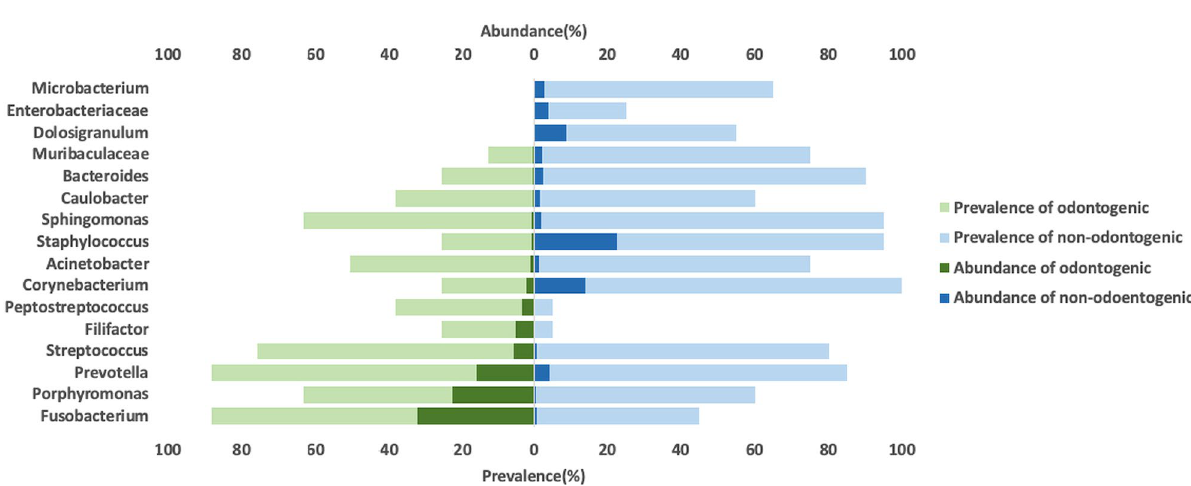
Figure 4. Relative abundance and prevalence based on 16S sequencing data in odontogenic and nonodontogenic rhinosinusitis samples. Abundance was calculated as the ratio of the number of read counts in each feature to total reads in each sample. Prevalence was calculated as the ratio of the number of samples that had a specific microbiome to the number of total samples in different groups. Only taxa with an average proportion of more than 1% in samples were represented in this figure. Green represents odontogenic rhinosinusitis, and blue represents nonodontogenic